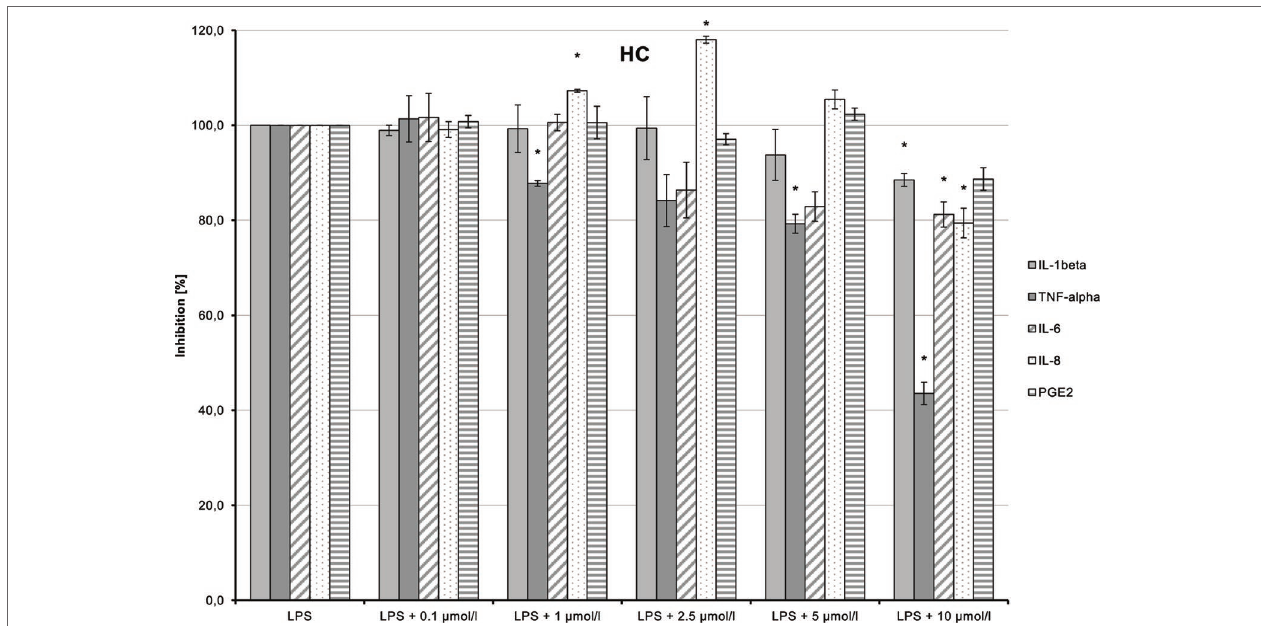
FigURE 13 | Anti‑inflammatory effect of n‑hexyl‑cannabidiolate (HC) on primary human monocytes; normalized to the induction by lipopolysaccharide (LPS) (without the addition of test compounds); n = 2 independent experiments; error bars show SEM, * p < 0.1.